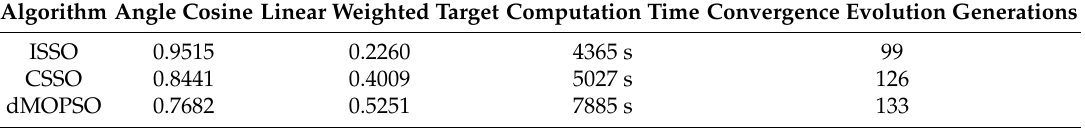
Table 11. The HILS evaluate results of different algorithms for rail transit line No.12 in Dalian